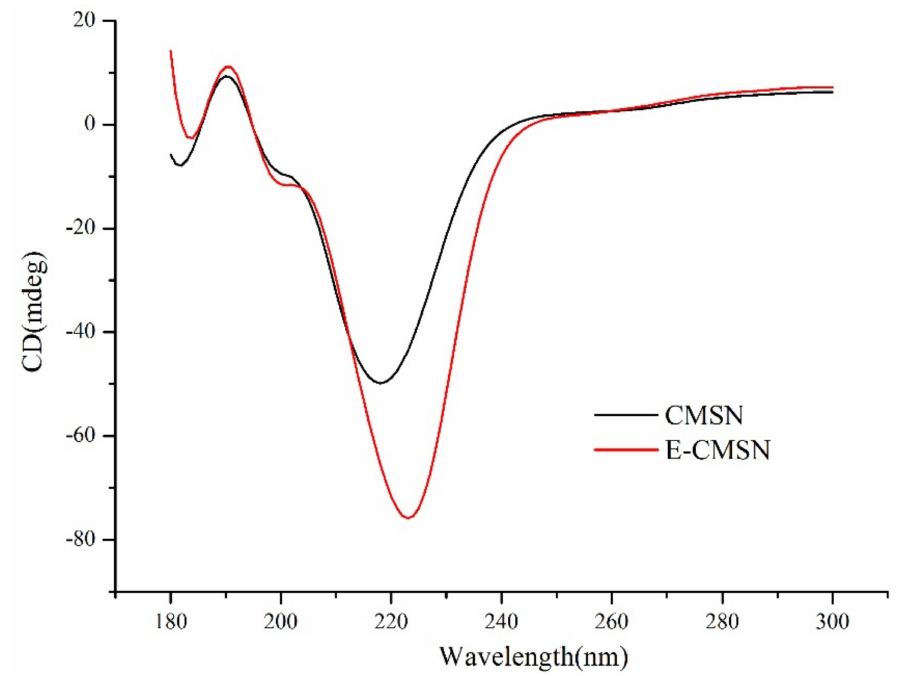
Figure 2. Circular dichroism spectra of CMSN and E-CMSN from 180 to 300 nm.